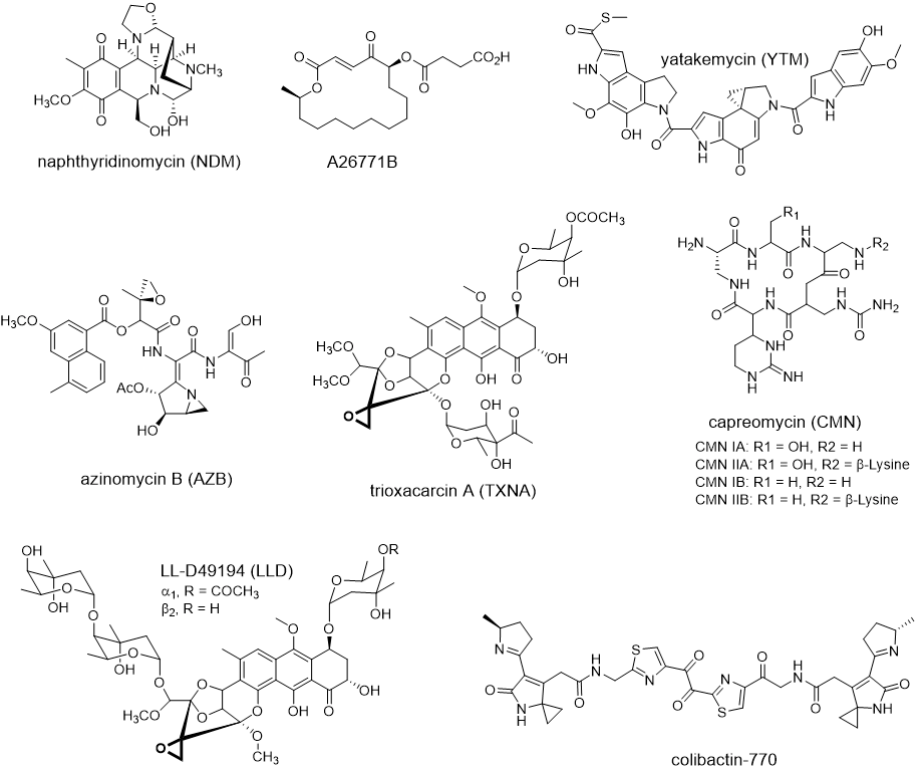
Figure 1. Representative natural products that employ temporal-spatial shielding or intracellular multi-level resistance model during biosynthesis.